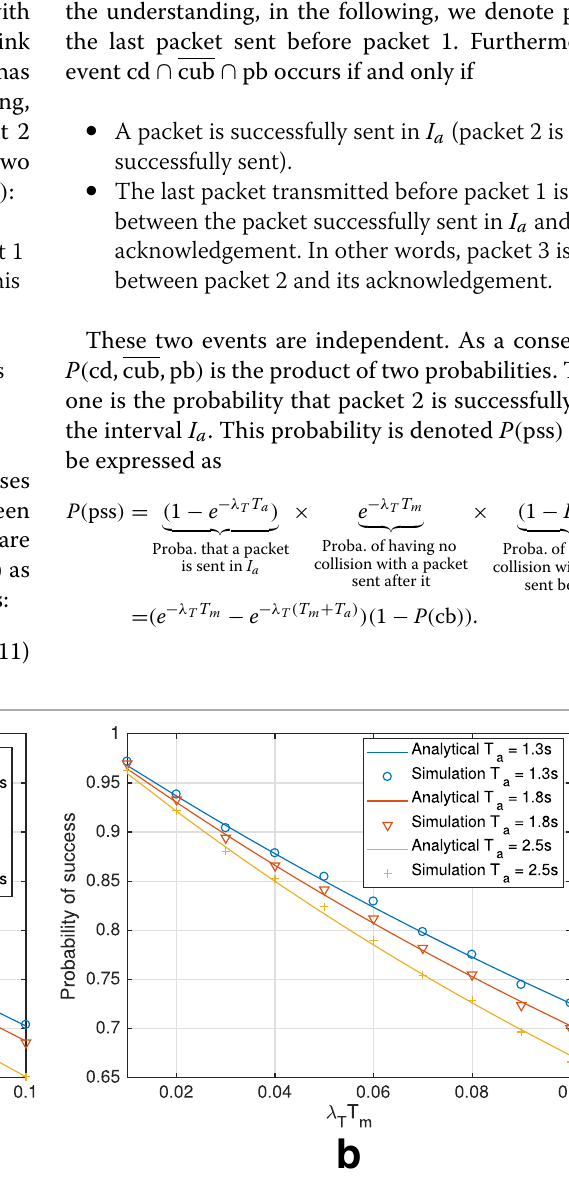
Fig. 7 Probability of success P ( sd ) versus λ T T m . These results are obtained with T d = 1 s and with various values of T a and T m which are compliant with the LoRaWAN standard. a T m = 1.6 s. b T m = 2.5